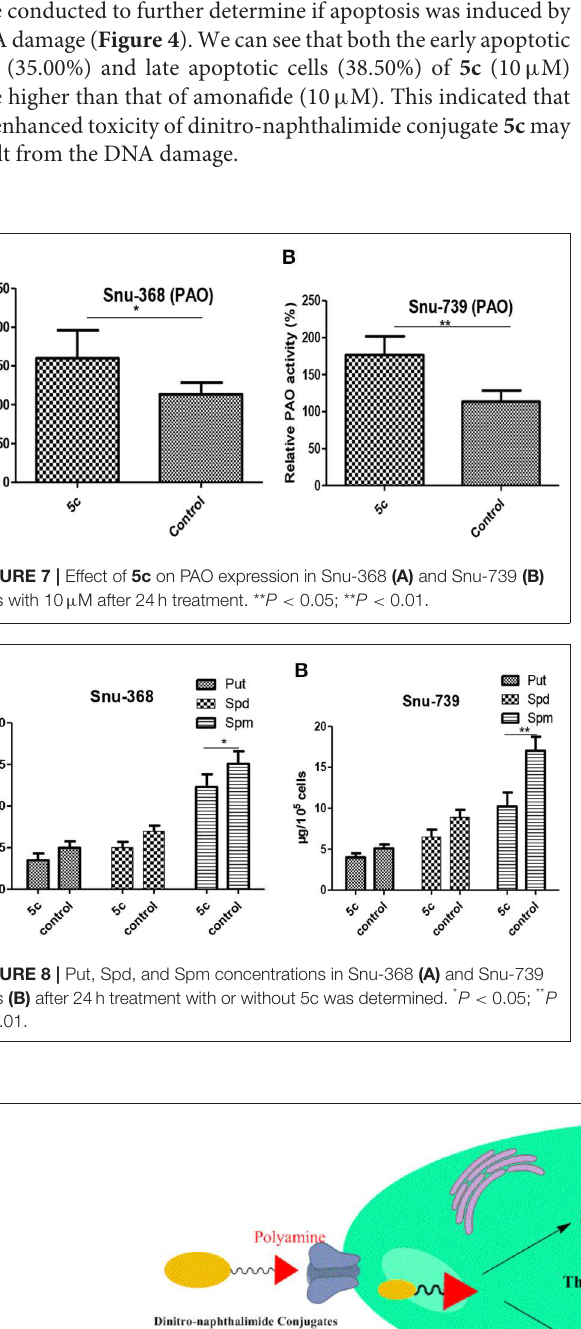
Frontiers in Chemistry |